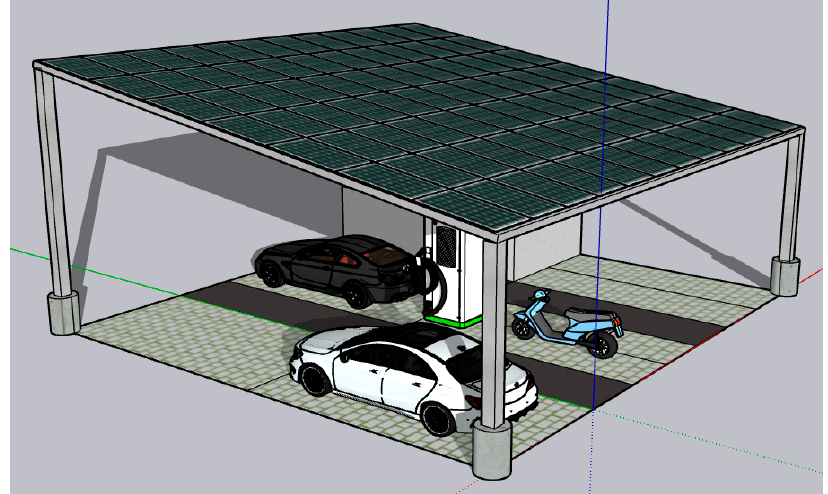
Figure 4. Schematic representation of carport charging infrastructure .